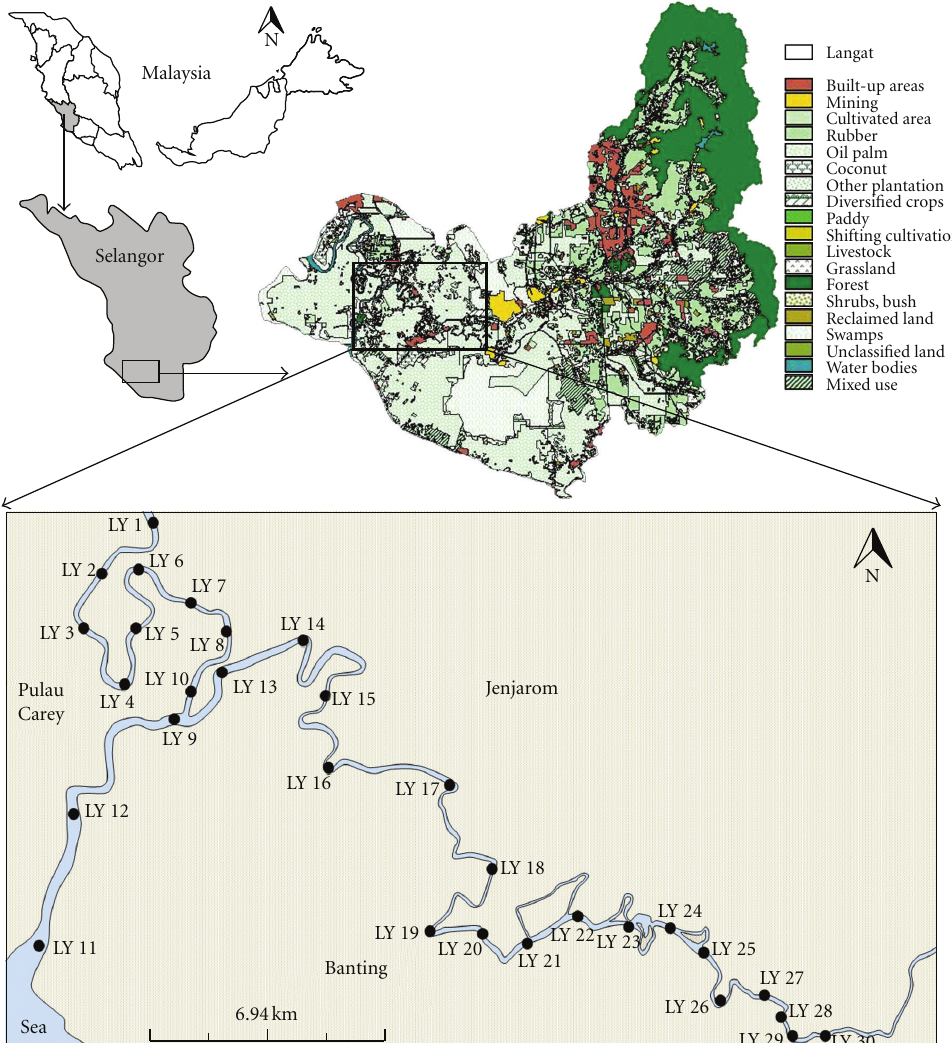
Figure 2: Map of sampling stations in Langat River. Source: JICA and MDGM